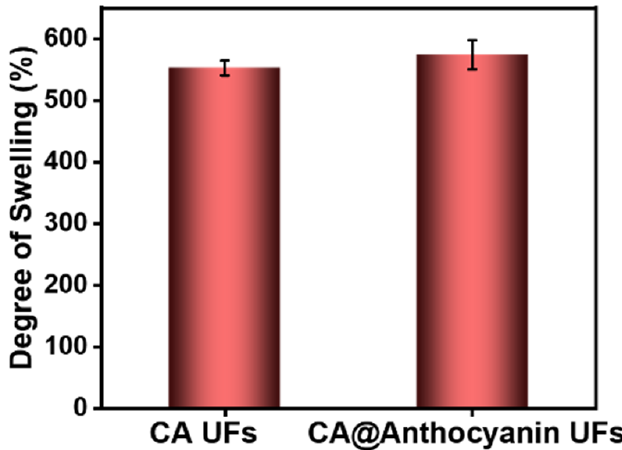
Figure 4. The degree of swelling of the neat CA UFs and the CA@Anthocyanin